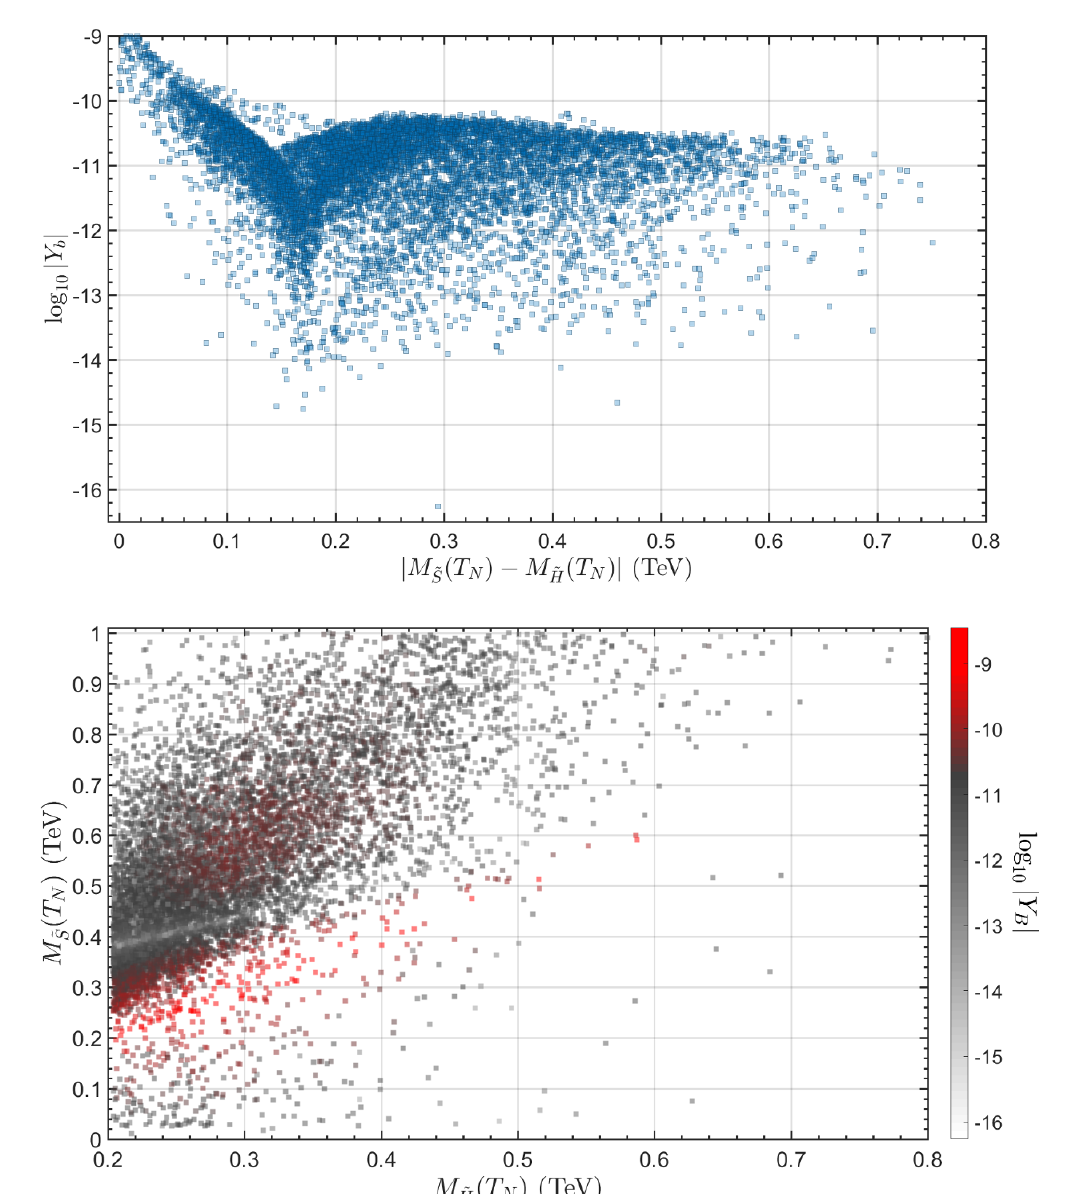
Figure 4 . Baryon asymmetry produced during a SFPT against the mass di(cid:11)erence of the singlino and Higgsino masses including the Debye masses (top panel) and a contour plot of the baryon asymmetry against the same aforementioned masses (bottom panel). The resonance is the dominant feature of the plot and it appears that in the SFPT case, one needs to be near the center of the resonance to produce the observed BAU unless (cid:1) (cid:12) is very large. The possibility of large (cid:1) (cid:12) in the NMSSM leads to the interesting possibility of o(cid:11) resonance baryogenesis.